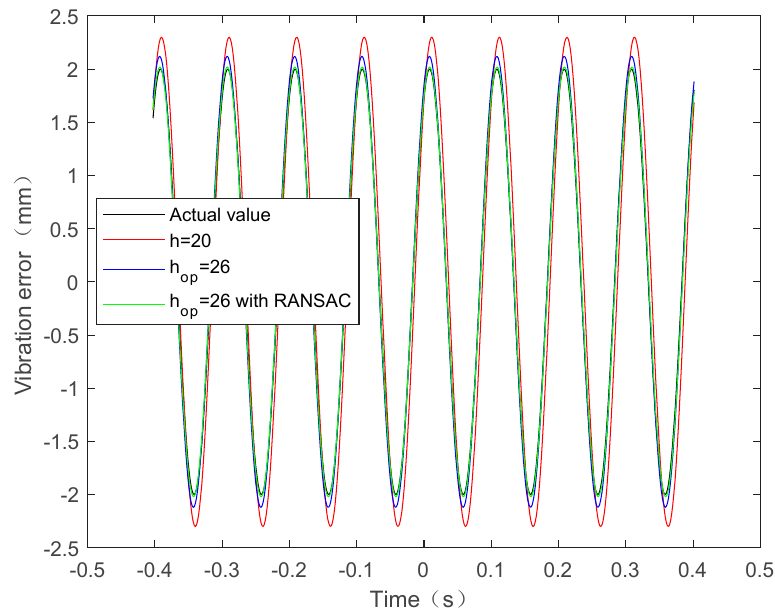
Figure 5. True and estimated single-component vibration error .